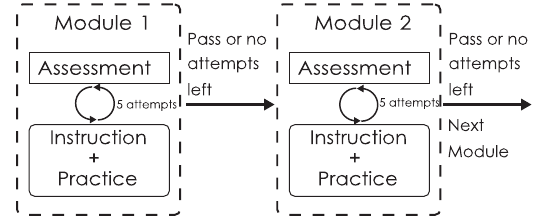
FIG. 1. Schematic illustration of the design of two online learning modules.